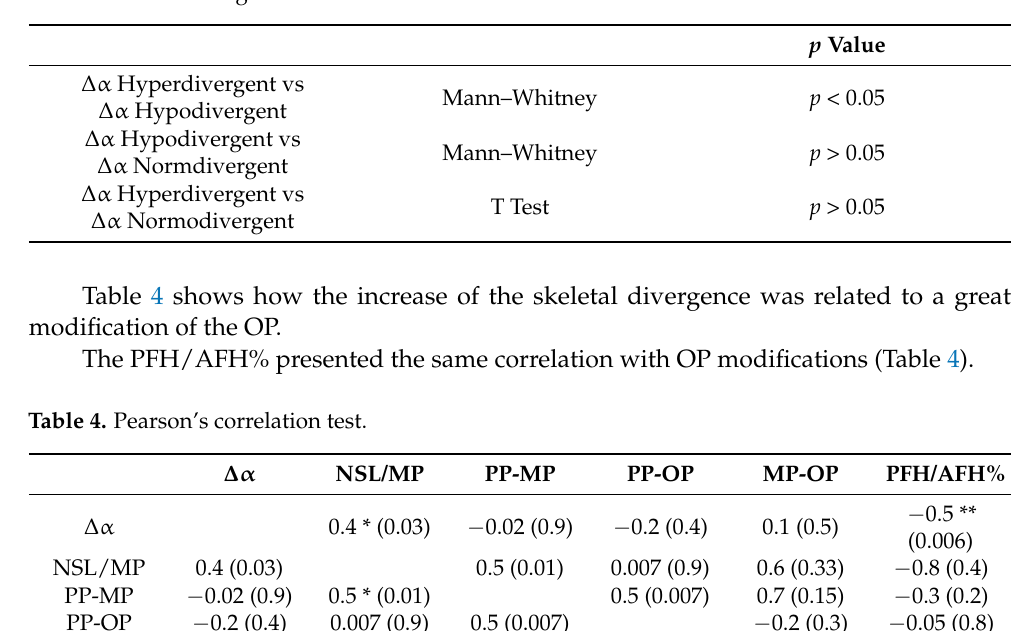
Table 3. Paired T-test and unpaired Mann–Whitney test used to evaluate correlation between ∆ α and vertical skeletal changes.